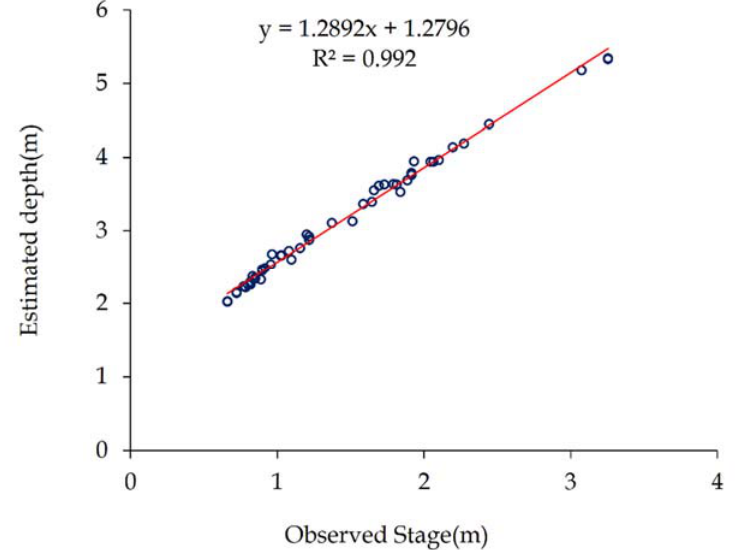
Figure 10. Time series of effective width obtained from Equation (2), average depth calculated using Equation (4) and average velocity calculated using Equation (5) at Tanggya gauge site from 1999–2018. The estimated average depth and in ‐ situ gauge stage data at Tanggya gauge shows a very strong correlation (R 2 = 0.992), providing strong support for the accuracy of our average depth estimation methodology (Figure 11).